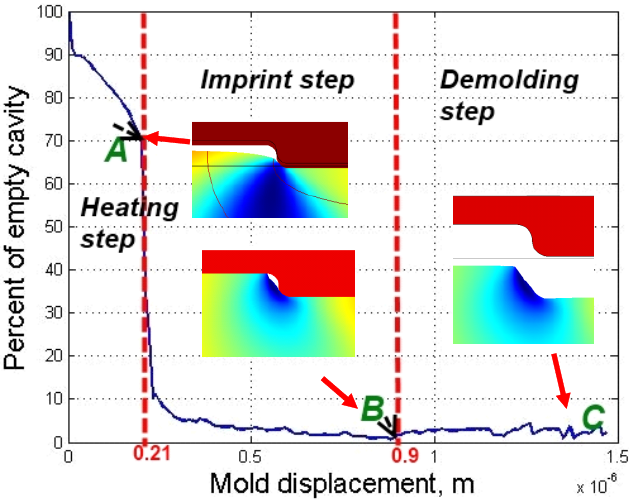
Figure 11. The dependence of non-filling cavity versus mold